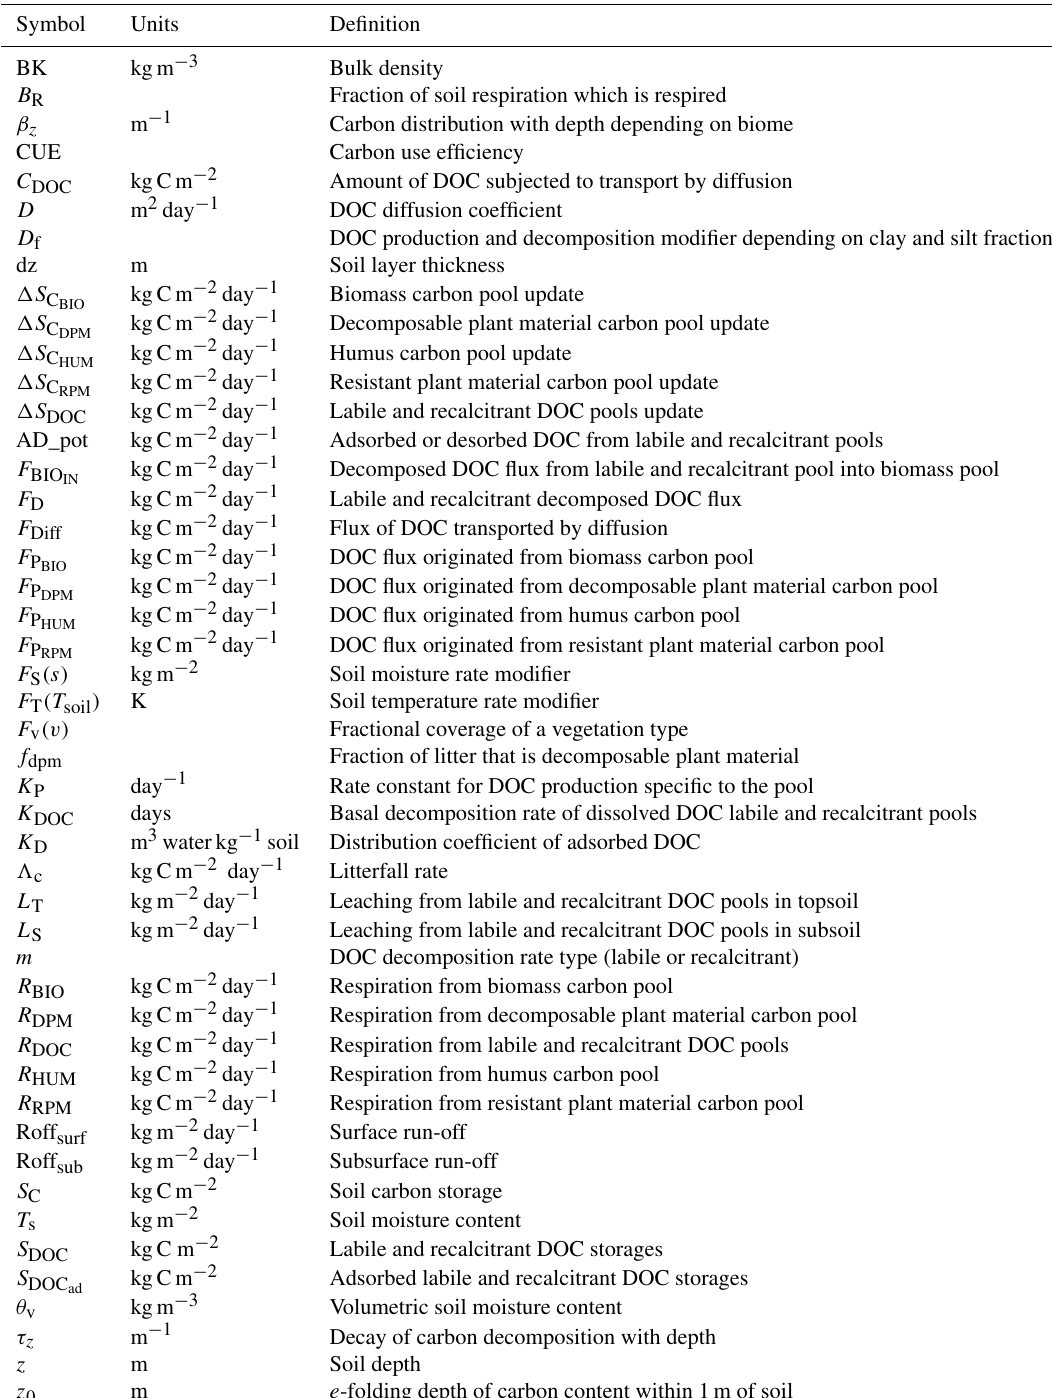
Table 2. Symbol definitions and